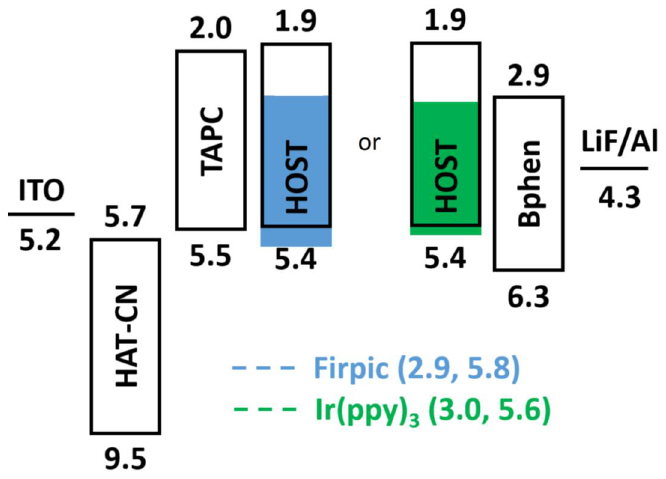
Figure 1. Structure and energy levels of blue and green PhOLEDs with host H1